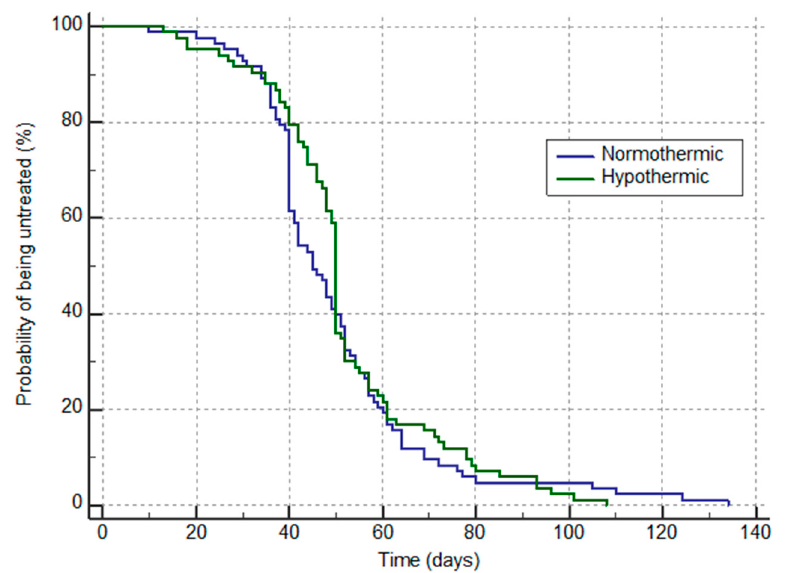
Figure 2. Kaplan–Meier plot of time to initiate supplemental therapy (chemotherapy or radiotherapy) in each group. The median time to initiate treatment is the time corresponding to probability of 50%. No significant difference was noticed between groups ( p = 0.46). Table 2. Surgical sites complications.